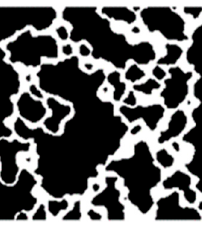
Figure 5. GRID01, constituted by squared pores, and a pore-throat to pore-body ratio of 2:1. The total number of pores is 64000. ( a ). Throats are 25 µm, and pores are 50 µm wide ( b ). Figure 6. HO49Y. Hostun sand is relatively homogeneous, characterized by well-sorted predomi- nantly quartz angular nantly quartz angular grains. Table 1. Values of porosity, average pore size and smallest pore size of the micromodels.